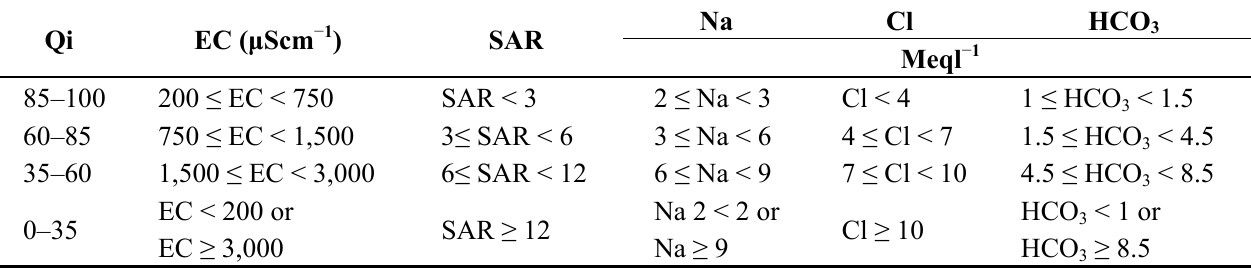
Table 1. Parameters of limiting values for quality measurement (Qi)